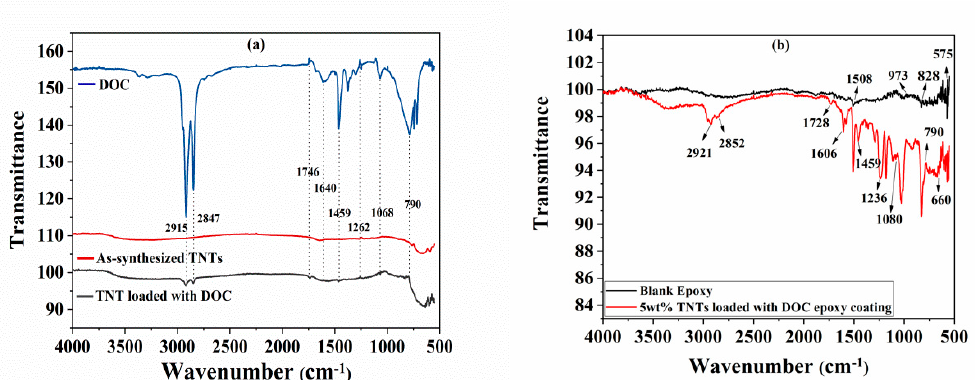
Figure 4. FTIR spectra of ( a ) as-synthesized TNTs, TNTs loaded with DOC, and pure DOC; ( b ) pure epoxy and epoxy coatings containing 5 wt.% of TNTs loaded with DOC.